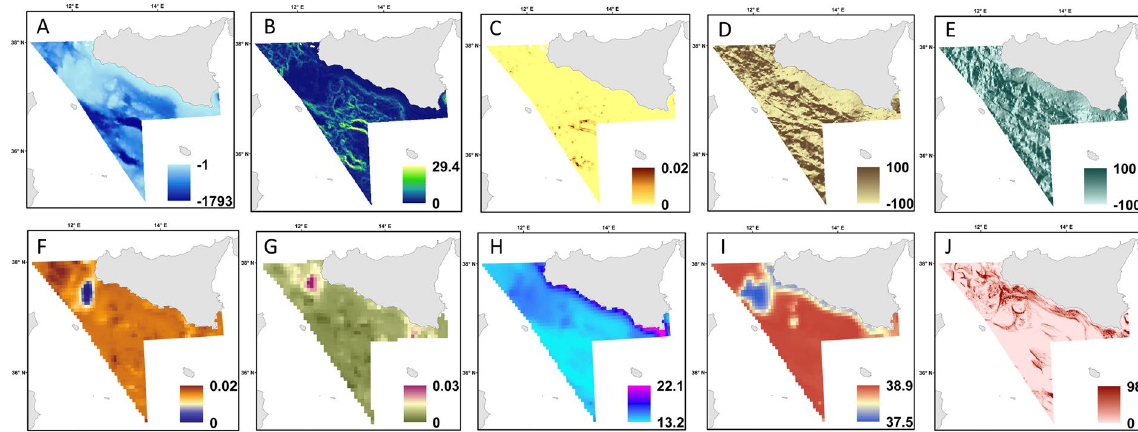
Figure 2. The spatial patterns of the environmental variables used to map the habitat models. These include ( A ) depth (m); (B ) slope (degrees) values range from to 0° to 90° with low slope values corresponding to flat terrain and higher values to steeper terrain; ( C ) rugosity values range from 0 (no terrain variation) to 1 (complete terrain variation); ( D ) aspect north-south and east-west ( E ) scaled to 100 (radians); ( F ) Current north-south (m/s); ( G ) Current west-east (m/s); ( H ) sea bottom temperature (°C); ( I ) sea bottom salinity (PSU); ( J ) Average distribution of the fishing effort between 2008–2013 in terms of number of fishing hours/year. These maps were created with ArcGIS version 10.3 http://www.esriitalia.it by Valentina